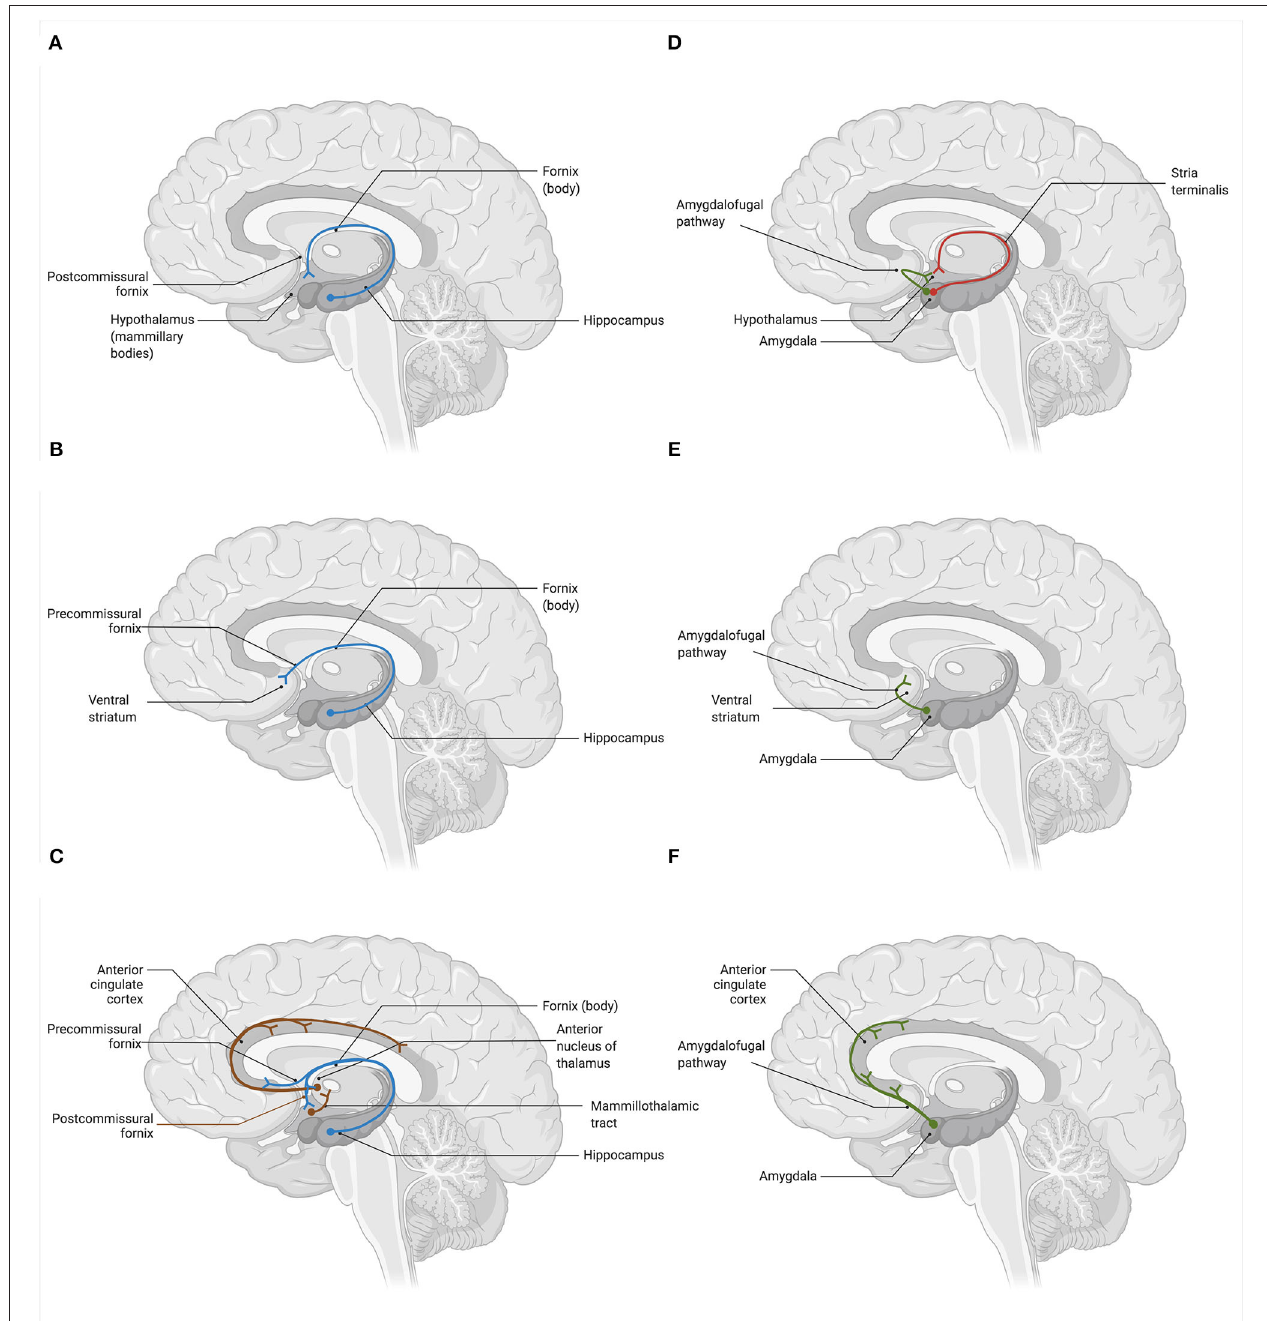
FIGURE 2 | Glutamatergic circuitry of the human brain: hippocampal and amygdalar efferent pathways (37). Glutamatergic neurons deeply innervate the subcorticolimbic areas of the brain, comprising an integral part of the basic reward, affective, and memory circuits. Hippocampus (HPC) and amygdala (AMYG) are the key centers that are potentially affected in depression both structurally (i.e., gray matter volume, cell atrophy, dendritic, and axonal density) and functionally (i.e., cell physiology). (A) The hippocampal-hypothalamic glutamate pathway connects the HPC with the mammillary bodies of the hypothalamus (HPT) via the postcommissural branch of the fornix. (B) The hippocampal-striatal-tegmental glutamate pathway interconnects the HPC and the ventral striatum via the precommissural branch of the fornix. Neurons of the NAc subsequently project to the VTA, where they modulate the firing of dopaminergic neurons. (C) The hippocampal-cingulate glutamate pathways represent two pathways that interconnect the HPC and the anterior cingulate cortex (ACC). Neurons of the HPC innervate ACC directly, via the precommisural branch of the fornix and the entorhinal cortex, as well as indirectly, by passing through the anterior nucleus of the thalamus (TH) via the postcommissural branch of the fornix. In turn, the ACC projects back to the entorhinal cortex of the parahippocampal gyrus, forming the circuit of Papez. (D) The amygdalo-hypothalamic glutamate pathways include two major efferent pathways of the AMYG. These are the dorsal stria terminalis route, which connects the